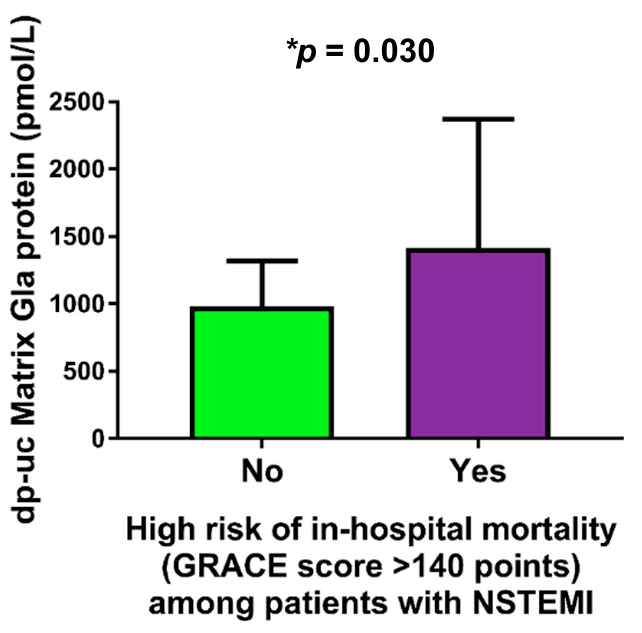
Figure 2. Comparison of dp-uc matrix Gla protein levels between NSTEMI patients with and without high risk of in-hospital mortality. Abbreviations: dp-ucMGP: dephosphorylated and uncarboxylated matrix Gla protein; NSTEMI: non-ST elevation myocardial infarction; GRACE: Global Registry of Acute Coronary Events; INR: international normalized ratio.